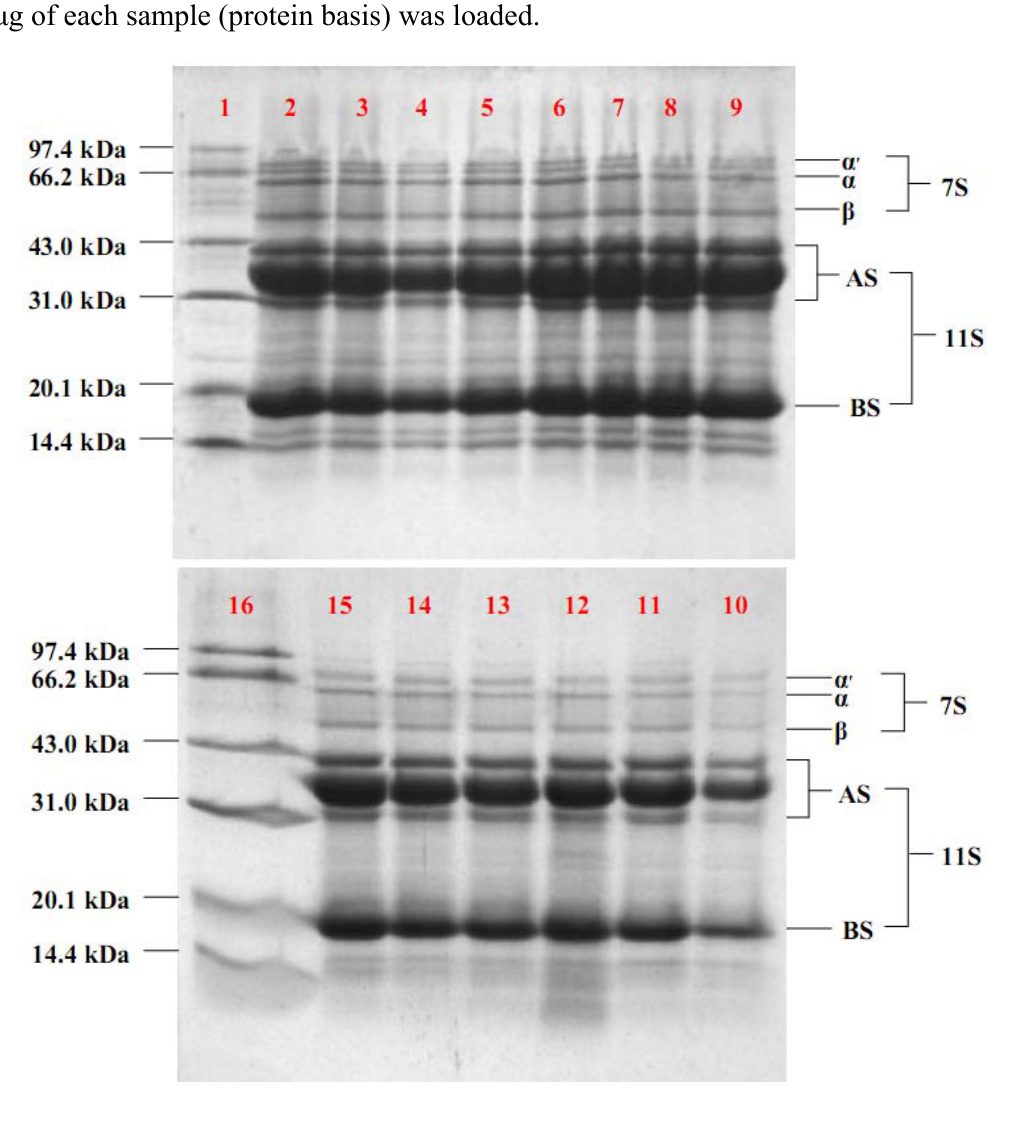
Figure 4. SDS-PAGE band patterns of the 11S-rich fractions obtained by different methods: 1 the molecular weight markers to which be pointed with arrows in the left; 2 pH 6.2; 3 pH 6.3; 4 pH 6.4; 5 pH 6.5; 6 pH 6.6; 7 SBS; 8 DTT; 9 ME; 10 6 h; 11 8 h; 12 10 h; 13 12 h; 14 14 h; 15 16 h; 16 markers. AS and BS indicated acidic and basic peptides of glycinin (11S) respectively, while α ', α and β indicated subunits of β -conglycinin